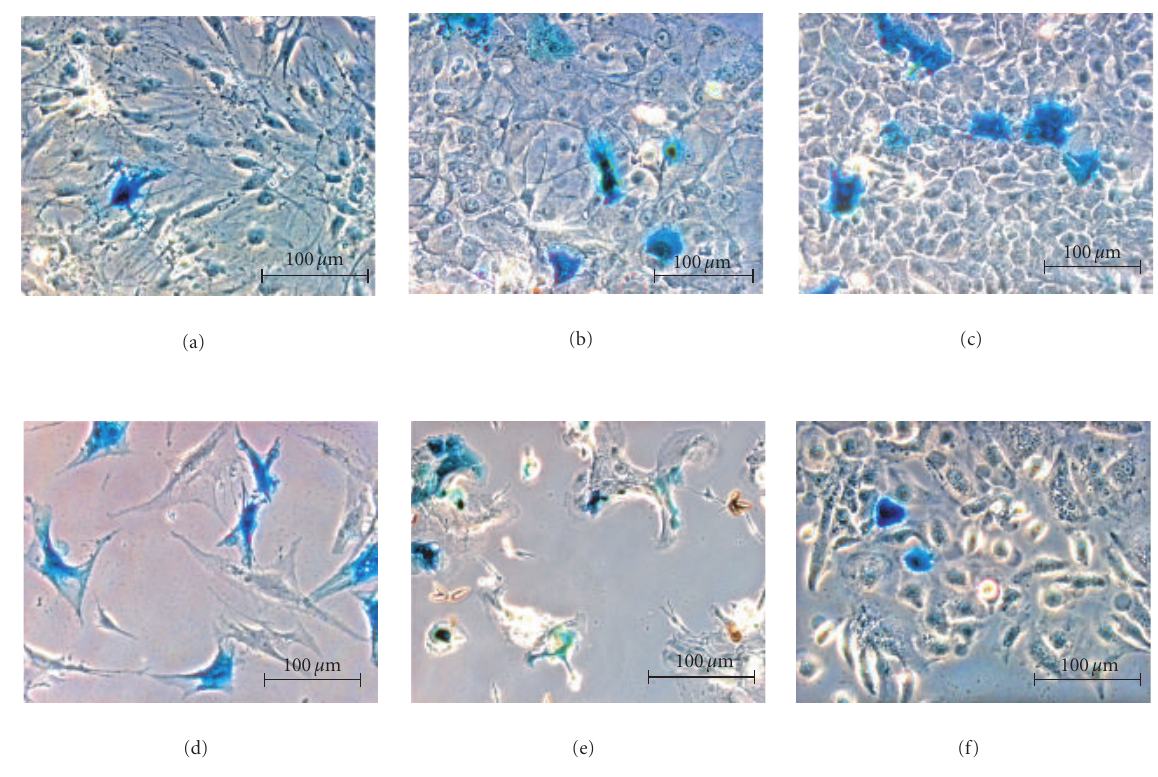
Figure 3: Cellular morphology . X-gal stained primary fibroblasts (a) and (d), primary keratinocytes (b) and (e), and HaCaT cells (c) and (f). Lipofection (a)–(c) and nucleofection techniques (d)–(f) were compared. Pictures were selected to demonstrate typical positively stained cells for both techniques. Pictures shown are not representative in comparison with the corresponding HPF counting of Figure 2 (Bar represents 100 μ m, magnification 200 (cid:2)